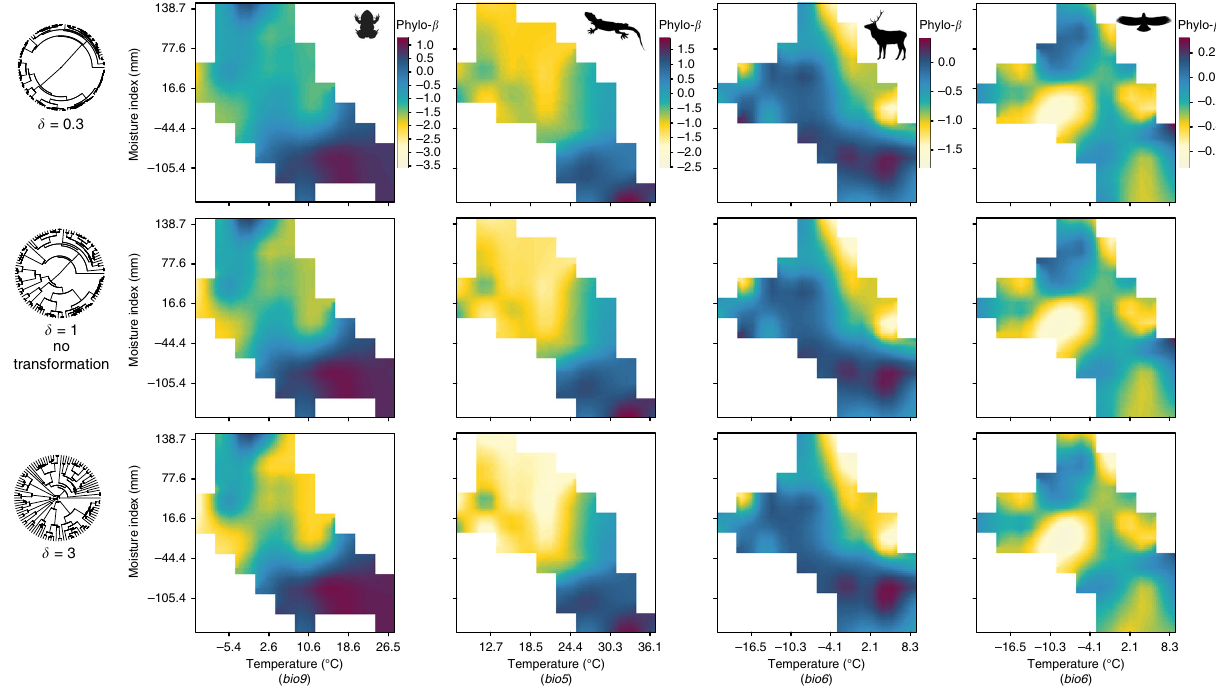
Fig. 3 True phylogenetic turnover in environmental space using rescaled phylogenetic trees. Phylo- ß is represented for amphibians (1st row), squamates (2nd row), mammals (3rd row), and birds (4th row) and is corrected for geographic land distance between sites. Rescaling of trees was based on delta transformation ( δ > 1 emphasizes recent branches; δ < 1 emphasizes deep branches). Note: for each clade, the same color range was applied to illustrate phylo- ß for comparison (therefore, the colors for δ = 1 do not exactly match with Fig. 2). Silhouette images were taken unchanged from phylopic.org, courtesy of Pedro de Siracusa (amphibians), Ghedo and T. Michael Keesey (squamates) both available under CC BY-SA 3.0 (creativecommons.org/ licenses/by-sa/3.0/), Steven Traver (mammals) available under CC0 1.0 (creativecommons.org/publicdomain/zero/1.0/), and Shyamal (birds) available